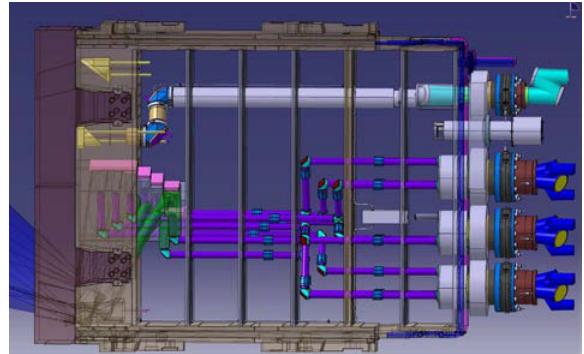
Fig. 3. CAD drawings of ITER CTS diagnostic in drawer #3 of equatorial port plug